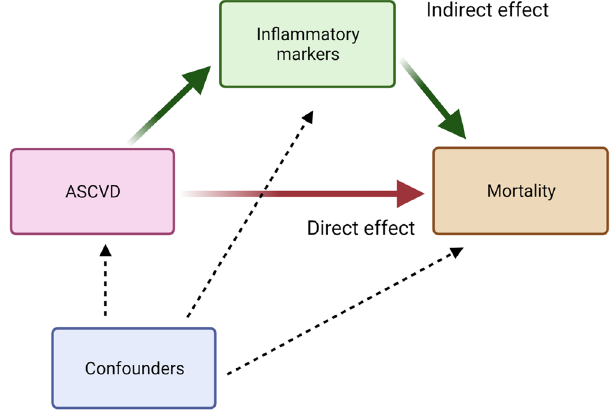
Figure 3. Causal directed acyclic graph (cDAG) for the analysis of the mediation of the association of Atherosclerotic cardiovascular disease (ASCVD) with mortality by inflammatory markers. Exposure: ASCVD: CAD + AMI − , CAD + AMI + and ATS were assessed in separate models. Mediator: Inflammatory markers: CRP, WBC and NL ratio were assessed in separate models Outcomes: All-cause and infection related mortality were assessed in separate models. Confounders: Age, gender, body mass index, diabetes mellitus, hypertension, cancer, chronic kidney disease (stage 3–5), asthma, chronic obstructive pulmonary disease, liver cirrhosis, transplant status, baseline sputum acid fast bacilli status, cavitary disease at baseline, metformin use, statin use, and calcium channel blocker use. ATS, pre-existing atherothrombotic stroke; CAD, pre-existing coronary artery disease; CAD + AMI − , Pre-existing coronary artery disease without prior acute myocardial infarction; protein; NL ratio: Neutrophil lymphocyte ratio; WBC: Total leukocyte count (× 10 3 /µL).